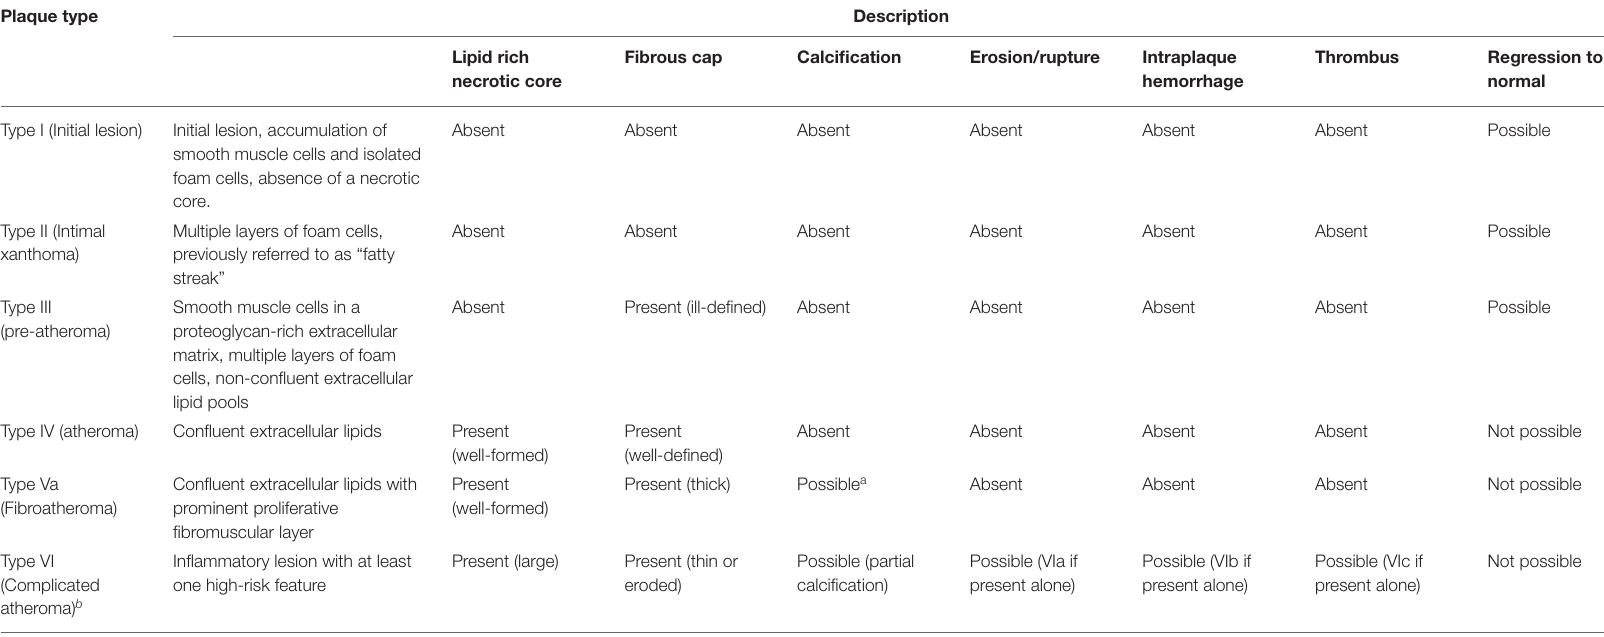
TABLE 1 | American Heart Association comprehensive morphological classification scheme for atherosclerotic lesions (32–34). Plaque